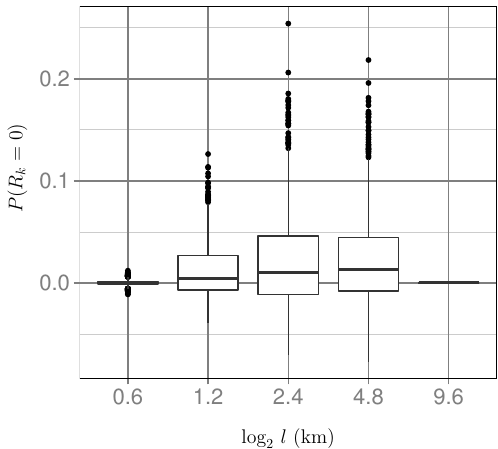
Figure 11. The difference between the probability of dry pixels as predicted, and as observed. Figure 9. The empirically fitted γ of the increments, averaged over all images, and its fit. The error bars denote the 25th and 75th percentiles. The behaviour of the function is linear in the middle of the scaling range, but breaks above log 2 l ≈ 6 or 30 km, and for the first scale, which is roughly in agreement with the scaling range found in the power spectrum.